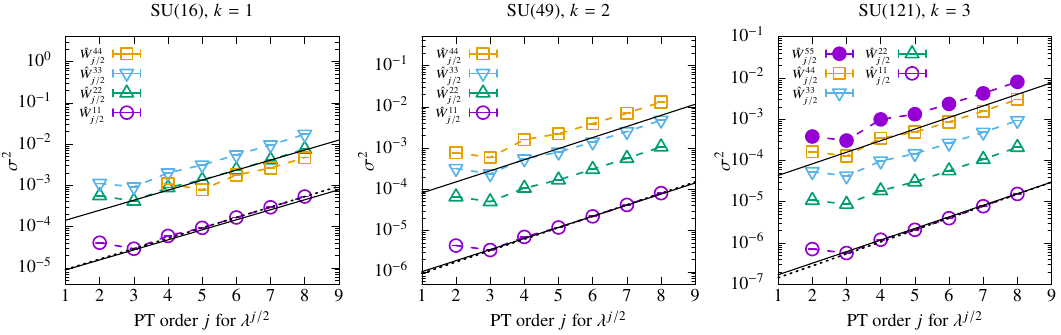
Figure 8. Variance (cid:27) 2 for ^ W RR at N MD = 32. Dotted lines are the results of a (cid:12)t to the j (cid:21) 5 j= 2 data. Solid lines represent the ansatz eq. (3.1) with R = 1 for all SU( N ) and with R = 2 ; 3 ; 4 for N = 16 ; 49 ; 121,